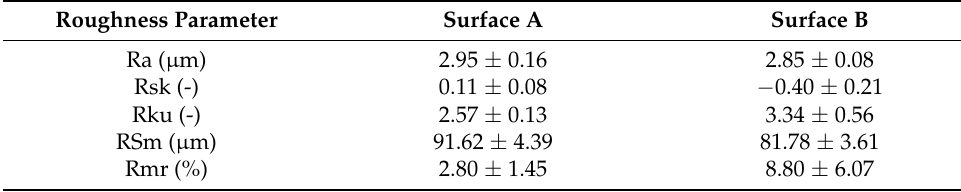
Table 4. Surface roughness parameters measurements results.